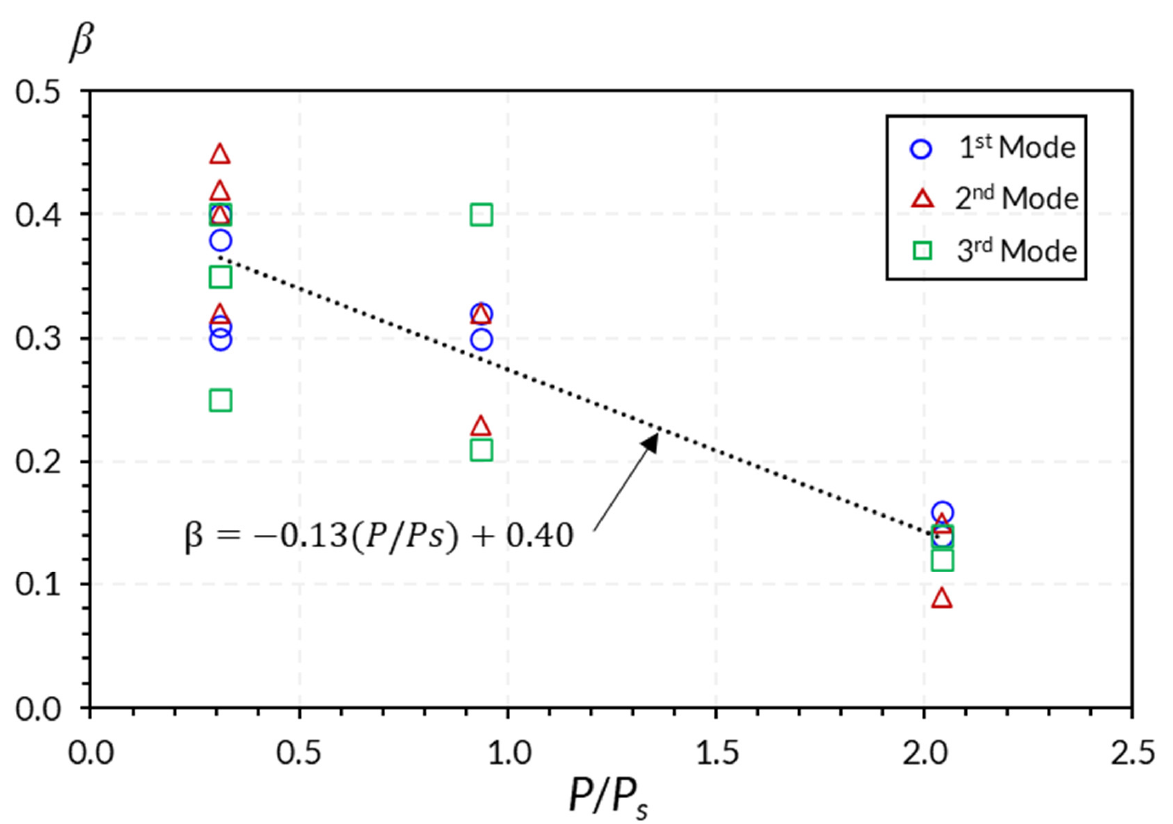
Figure 12. Relationship between β and P / P s .